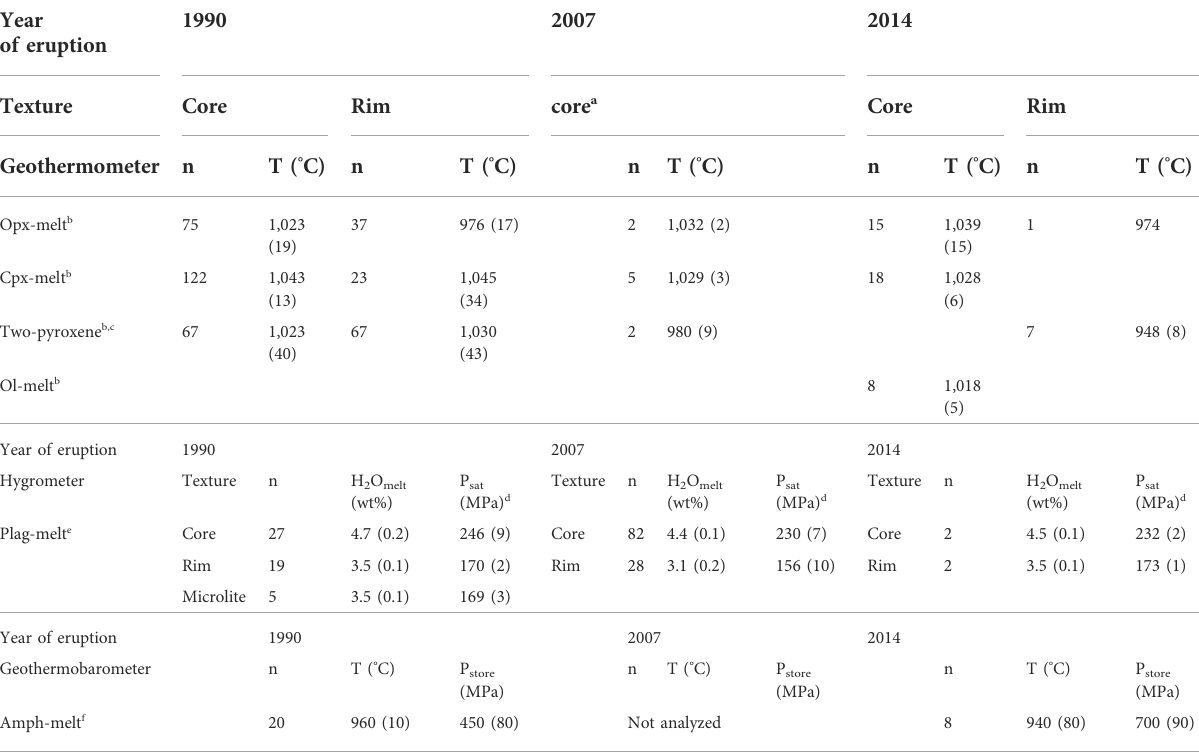
TABLE 4 New storage condition estimates from mineral-melt geothermobarometers, hygrometers, and H 2 O – CO 2 saturation models for the 1990, 2007, and 2014 mineral populations. Year of